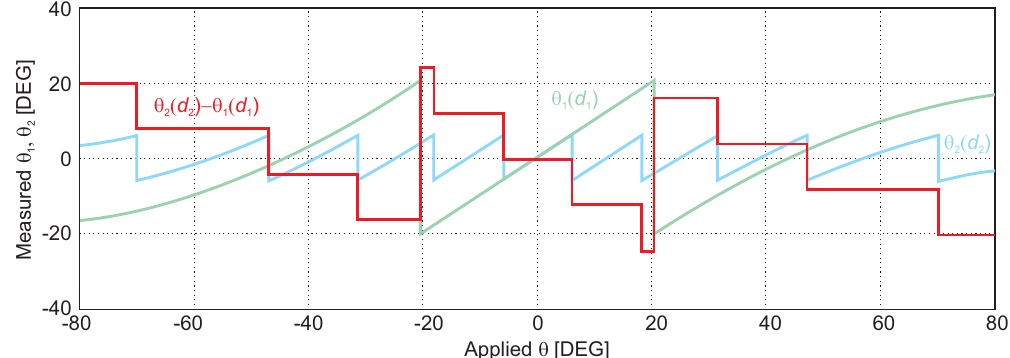
Figure 13. System simulation results for AoA analysis for two six-port interferometers shown in Figure 12 featuring different antenna distances and resulting in calculated angles θ 1 (in green) and θ 2 (in blue), respectively. The difference between both graphs (red curve) leads to a step-like graph indicating the respective period for ambiguity elimination (system measurements presented in